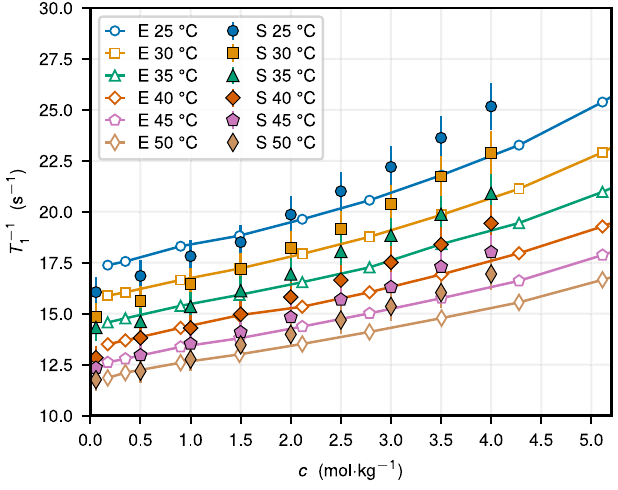
Fig. 3 | Concentration and temperature dependence of the quadrupolar relaxationrate. T (cid:3) 1 1 of 23 Na + inaqueousNaClasafunctionofthesaltconcentration c as obtained in experiments (E, solid lines and open symbols) and simulations (S, fi lled symbols) for different temperatures.The error bars forsimulation results are associated with the approximation for incorporating the electron cloud contribu- tion to the